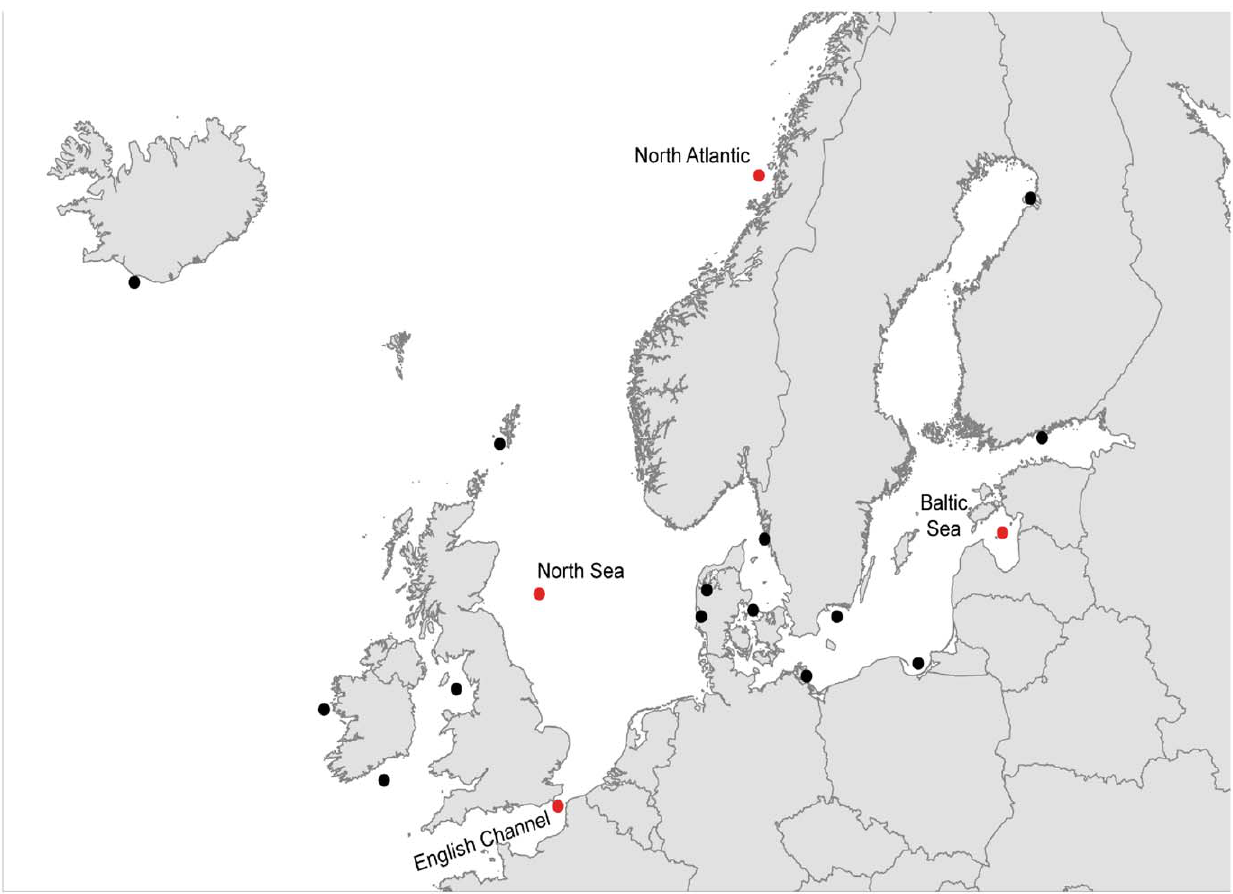
Figure 1. Location of the 18 samples used in this study. The eight sequenced ascertainment individuals (2 per location) came from the four sampling sites denoted in red.